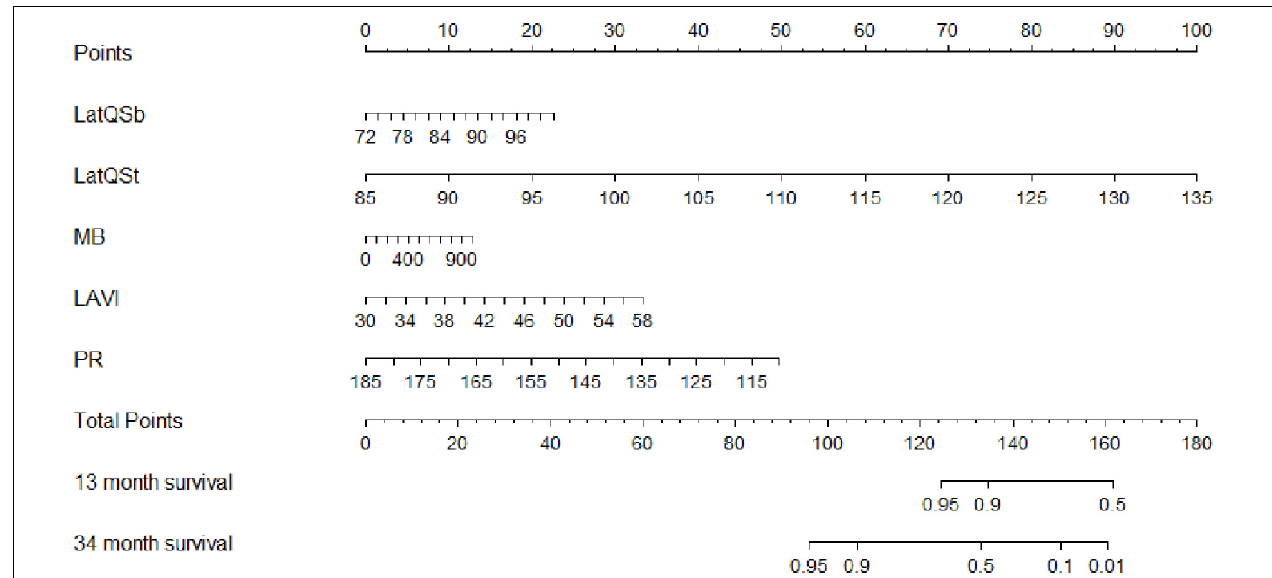
FIGURE 3 | Nomogram to estimate the risk of HF in HCM. To use the nomogram, find the position of each variable on the corresponding axis, draw a line to the points axis for the number of points, add the points from all of the variables, and draw a line from the total points axis to determine the HF probabilities at the lower line of the nomogram. Lat, lateral wall; Qsb, from the onset of QRS wave on ECG to the beginning of S wave on TDI; Qst, from the onset of QRS wave on ECG to the top of S wave on TDI; MB, myoglobin; LAVI, left atrial volume index; PR, PR interval.